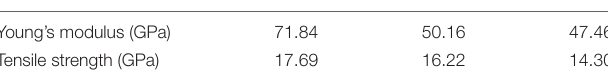
TABLE 3 | Young’s modulus of NASH gel models with different Na/Al ratios.